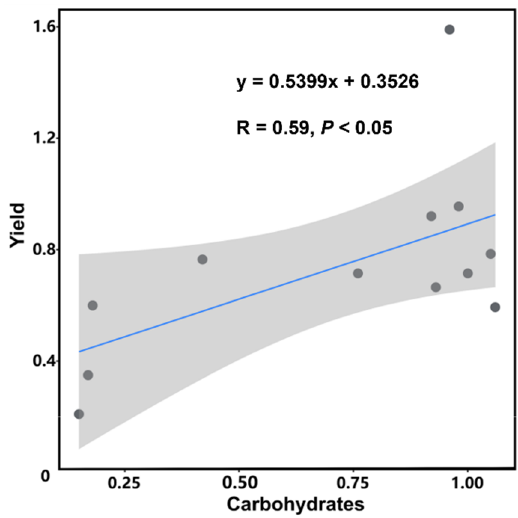
Figure 7. Correlation between the cucumber yield and carbohydrate utilization based on CLPP.